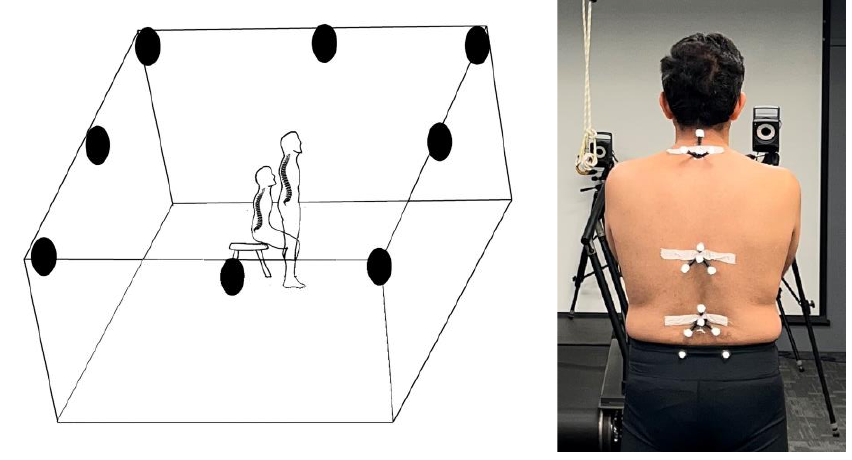
Figure 1. Capture volume and cameras ( ) placement ( left ) and marker placement ( right ).